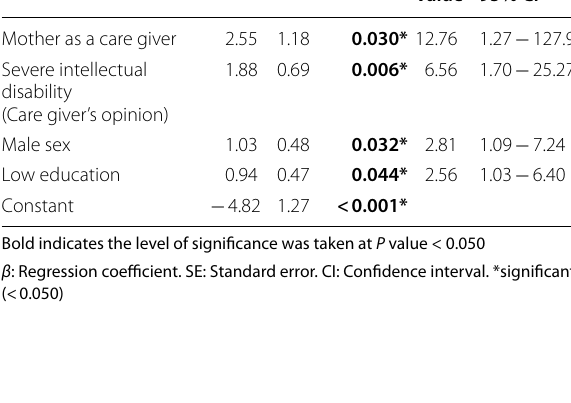
Table 3 Logistic regression for factors affecting having home‑ based training